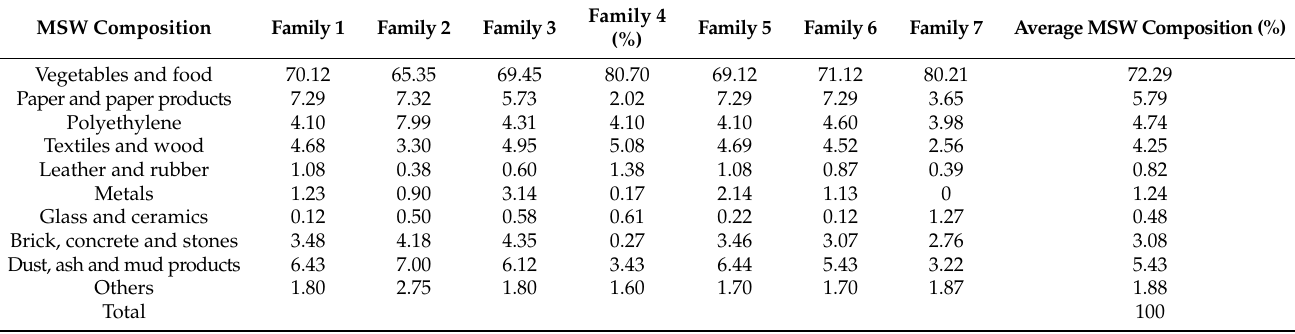
Table 6. Physical composition of MSW collected from seven different families. MSW Composition